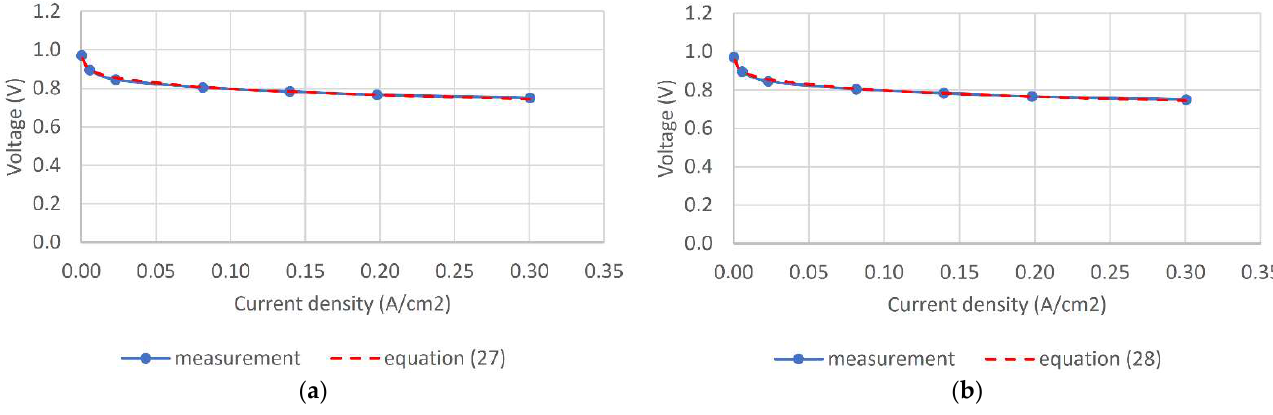
Figure 8. Measured polarization curve and its fitting curves: ( a ) fitting curve of Equation (27), ( b ) fitting curve of Equation (28).